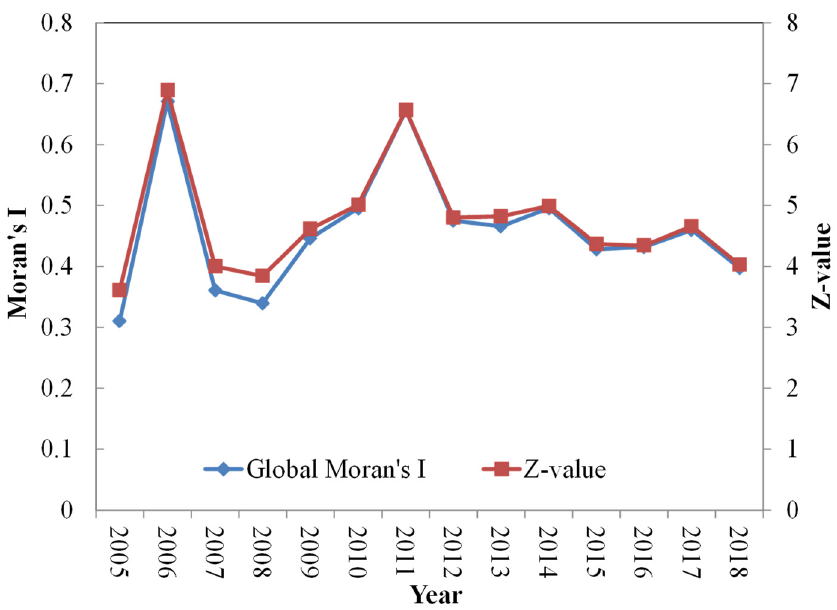
Figure 4. Change in the Moran’s I index of the RNCUE values in Chongqing from 2005 to 2018.